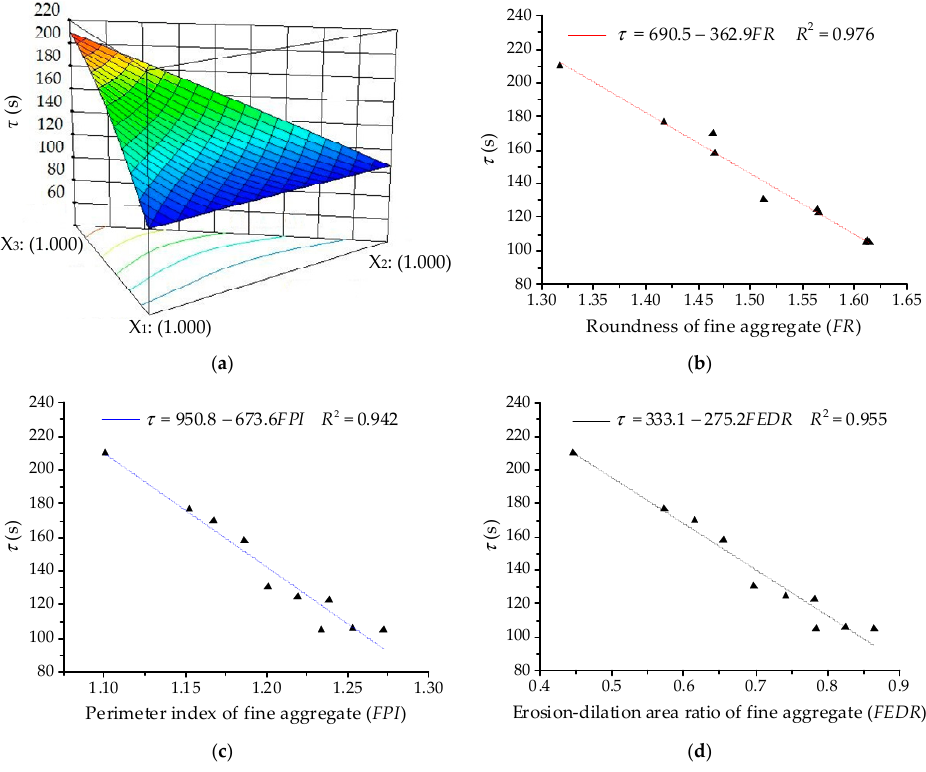
Figure 8. Relationships between τ and fine aggregates: ( a ) Response surface plot for component proportion and τ ; ( b ) FR and τ ; ( c ) FPI and τ ; ( d ) FEDR and τ .